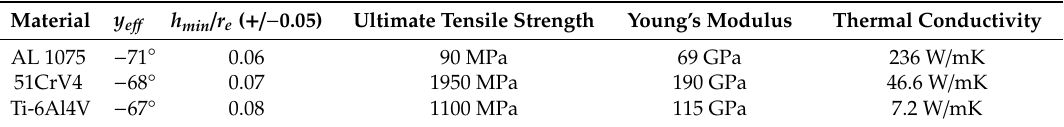
Table 2. Material properties, and empirically determined material-specific y eff and h min /r e values for the relevant workpieces studied.